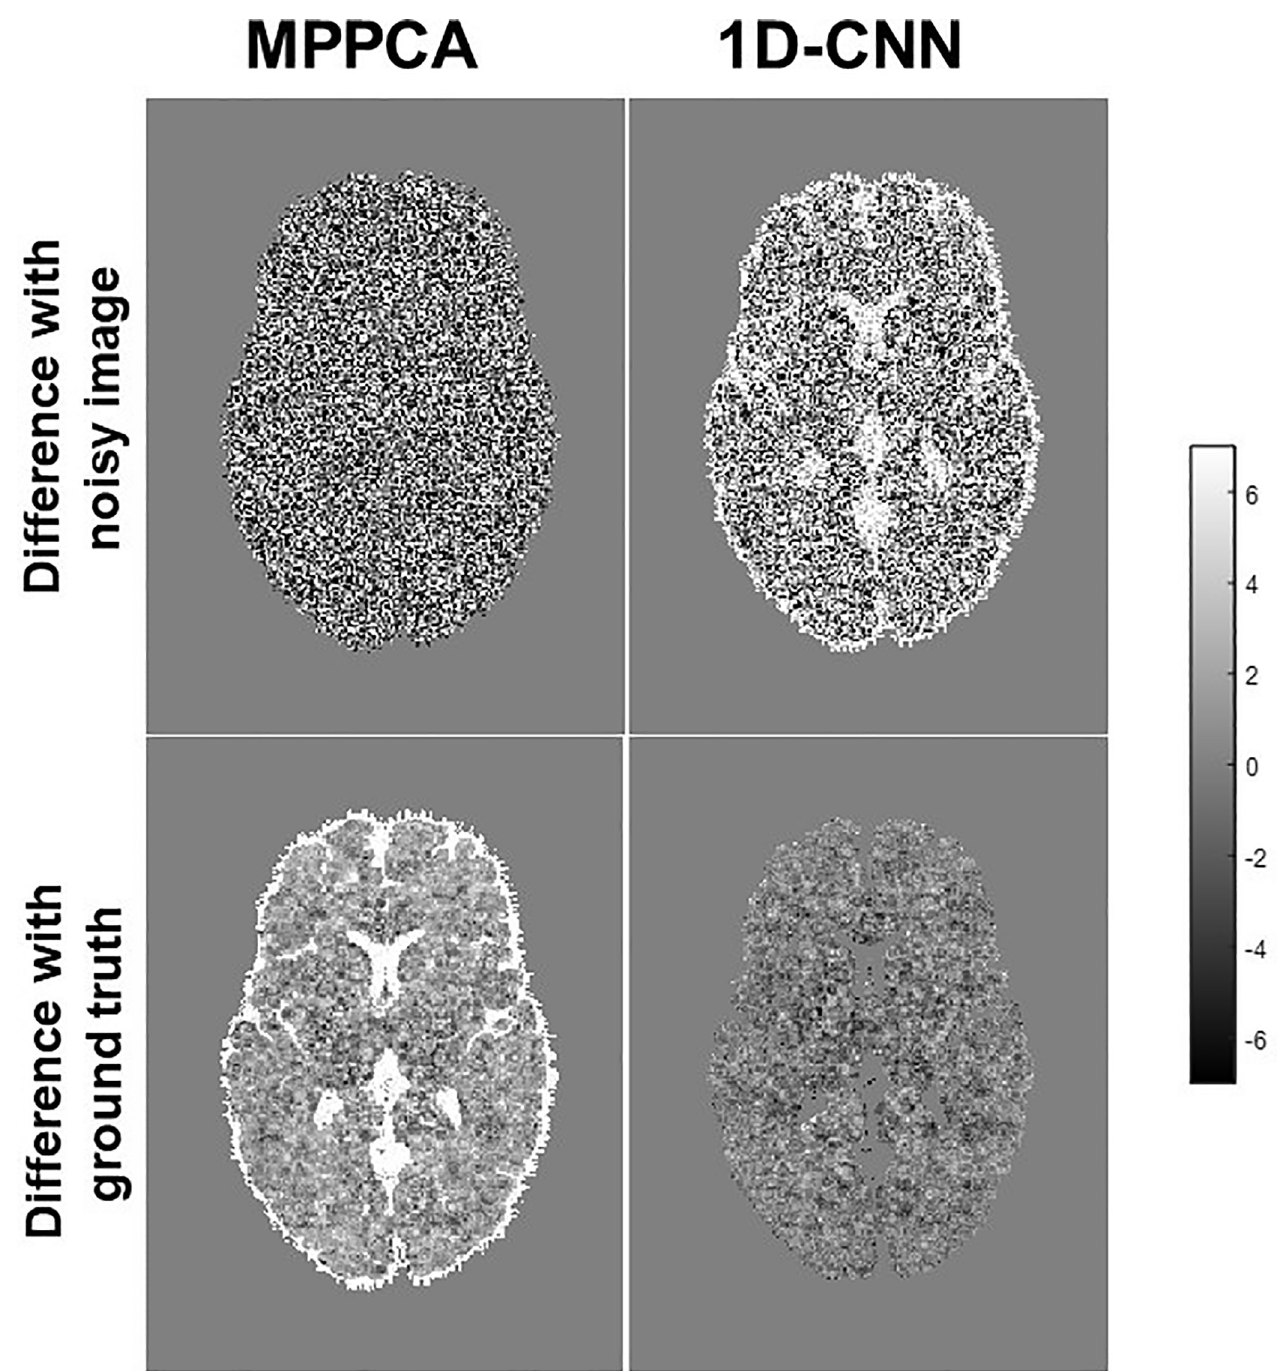
Fig 3. Difference (arbitrary unit) between denoised image and original noisy image (top) and the ground truth (bottom) for MP-PCA and 1D-CNN from simulation. noisy than the original SoS images. A representative slice of the SoS image, the SENSE1 image, and the dSoS image for one subject are shown in Fig 5A for b = 0 s/mm 2 , b = 1000 s/mm 2 , and b = 2500 s/mm 2 . The average correlation coefficients between SENSE1 and dSoS images were